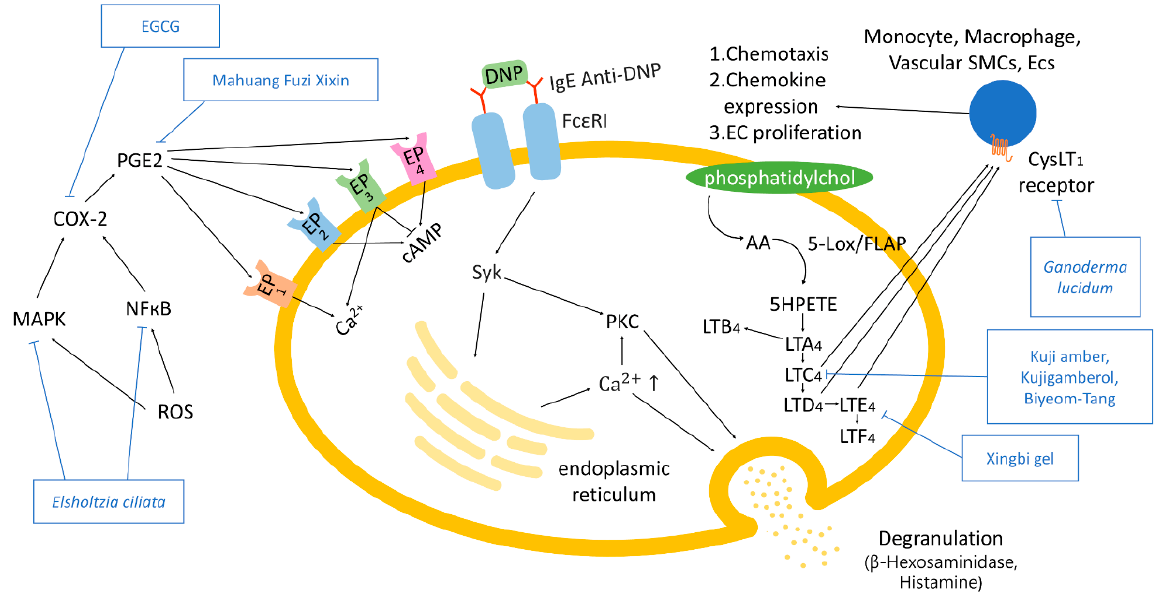
Figure 4. LO pathway, PGE 2 synthesis and signaling pathway. MAPK, mitogen-activated protein kinase; COX-2, cyclooxygenase-2; NF κ B, nuclear factor- κ B; ROS, reactive oxygen species; PGE 2 , prostaglandin E2; DNP, dinitrophenyl; IgE, immunoglobulin E; Fc ε RI, high-affinity IgE receptor; Syk, spleen tyrosine kinase; PKC, protein kinase C; AA, arachidonic acid; 5-Lox, arachidonate 5-lipoxygenase; FLAP, 5-LO-activating protein; 5HPETE, 5-hydroperoxyeicosatetraenoic acid; LT, leukotriene; EC, endothelial cell; SMC, smooth muscle cell; CysLT1, cysteinyl leukotriene 1; EGCG, Epigallocatechin